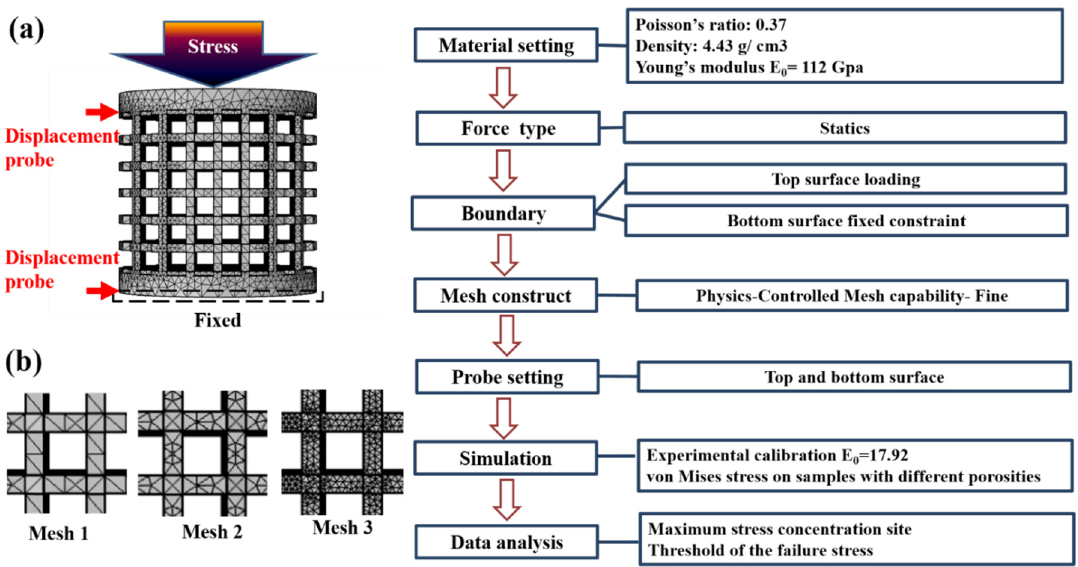
Figure 2. ( a ) Flowchart, meshing and boundary condition of the COMSOL FEA simulation. ( b ) Mesh distribution of different settings: mesh 1 (default, fine), mesh 2 (default, extra fine), and mesh 3 (self-set).